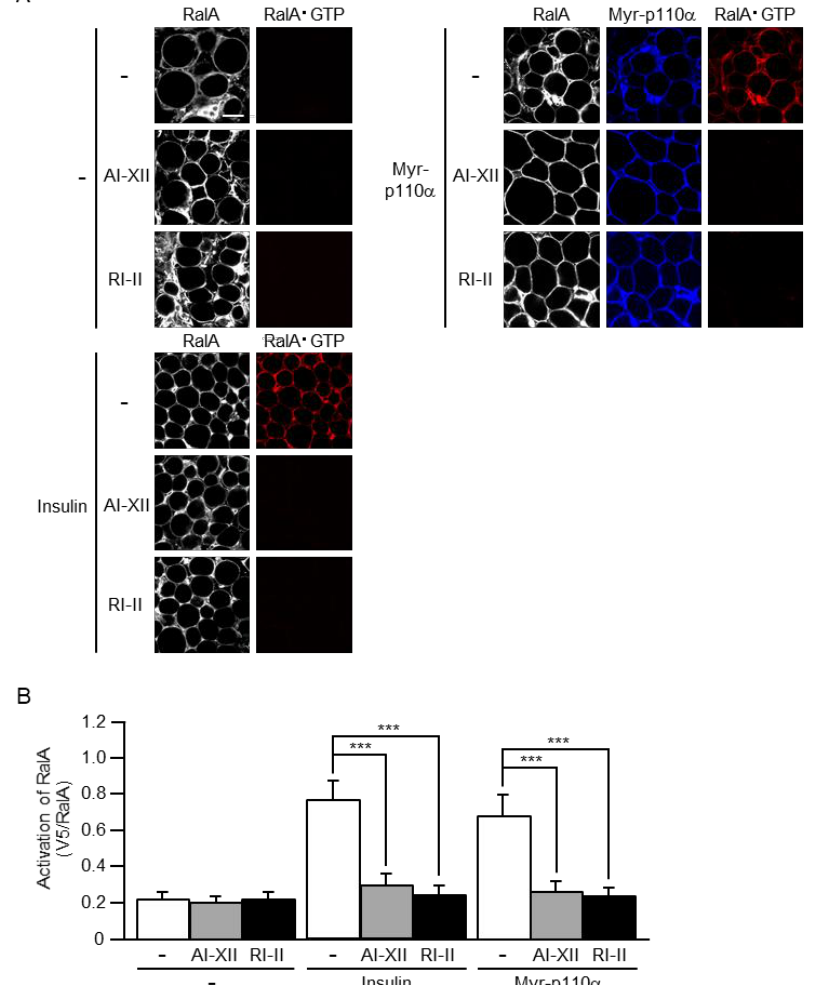
Figure 8. Inhibition of the activation of RalA induced by insulin or a constitutively activated mutant of PI3K by Akt2- and Rac1-specific inhibitors. ( A ) Endogenous RalA was visualized by immunofluorescent microscopy using an anti-RalA antibody. Myr-p110 α was visualized by immunofluorescent microscopy using an anti-HA antibody. RalA · GTP was visualized by immunofluorescent microscopy using the activation-specific probe GST-V5 × 3-Sec5(1–99) and an anti-V5 antibody. In some experiments, excised sWAT was treated with AI-XII (5 µ M) or RI-II (25 µ M) for 2 h. Scale bar, 50 µ m. ( B ) The activation of RalA shown in ( A ) was quantified. Data are shown as means ± S.E. ( n = 15). *** p <